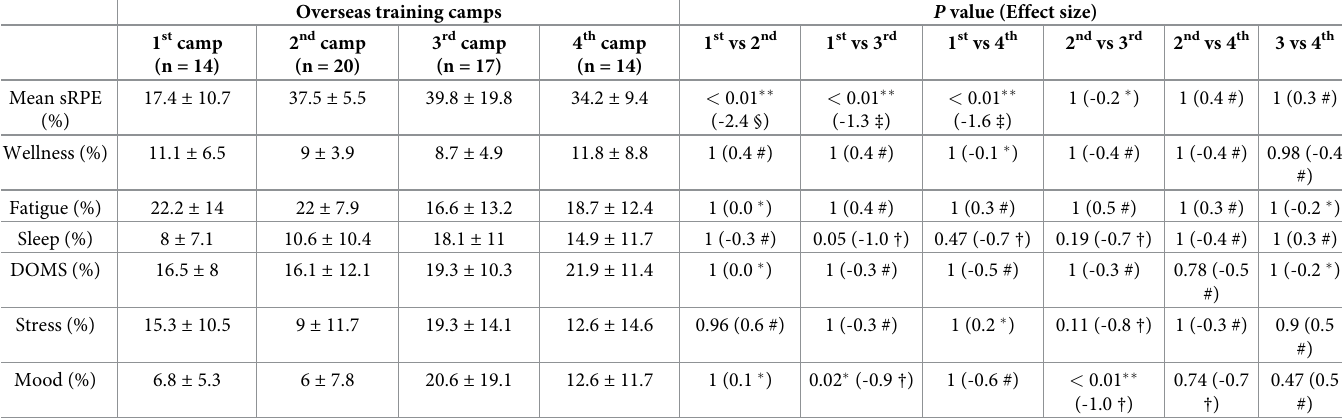
Table 3. Coefficient of variation of internal load (session rating of perceived exertion) and wellness status (wellness, fatigue, delayed onset muscle soreness, sleep, stress, and mood) in four overseas training